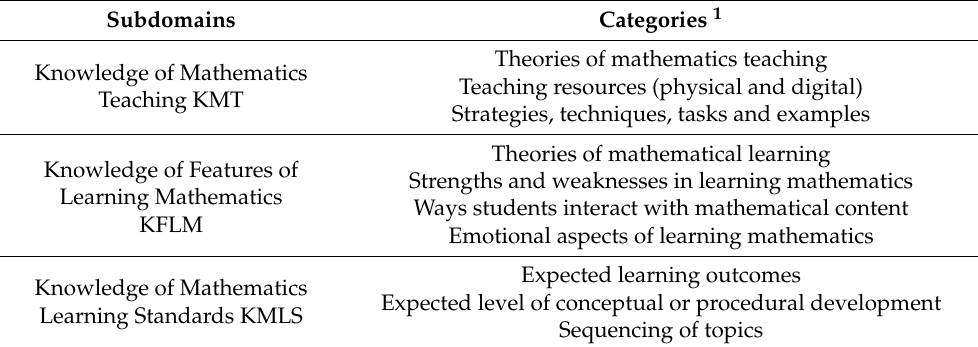
Table 2. Categories of the PCK domain